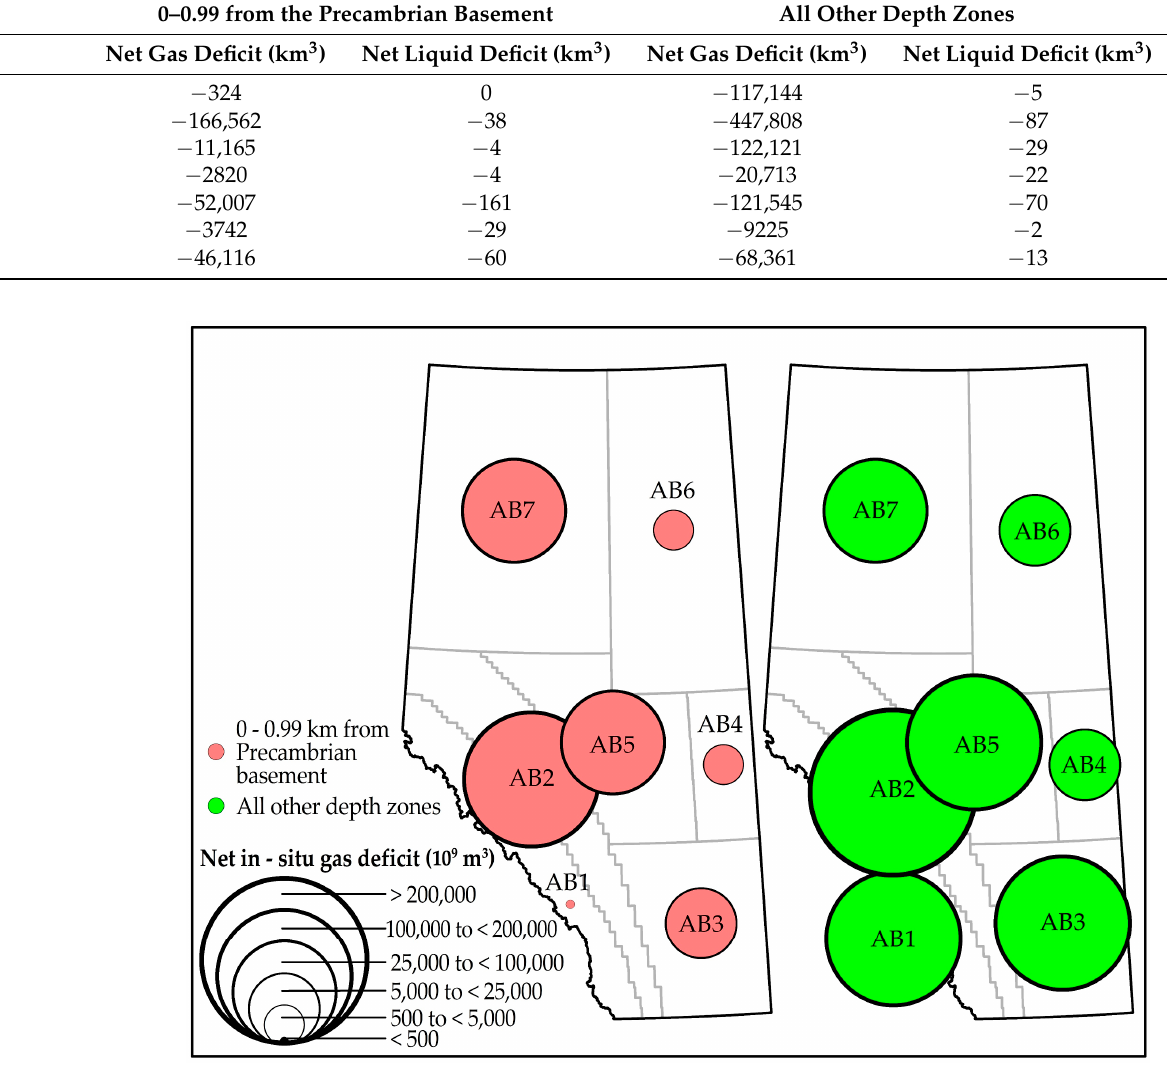
Figure 15. Calculated net in situ gas deficit in the Alberta Basin (as of December 31, 2020). Source data extracted from geoLOGIC Systems databases © 2020.